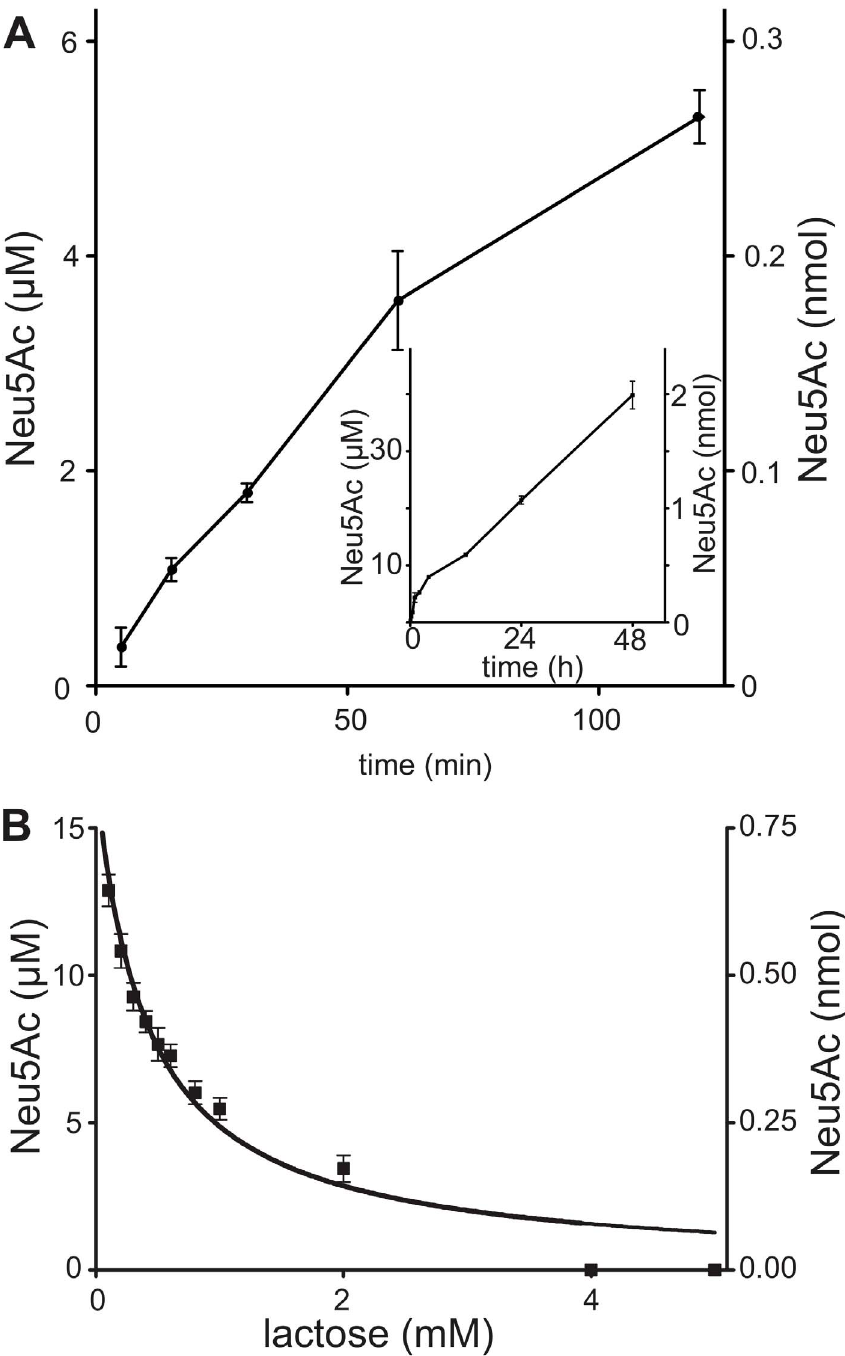
Figure 5. Sialidase activity of TconTS4. A : Recombinant TconTS4 was incubated with 100 m g fetuin (600 m M bound Sia) for the times indicated (see insert for long term reactions) and free Sia determined by HPAEC-PAD as described under Methods. Data points are means 6 standard deviations of 3 independent reactions each triplicated. B : Recombinant TconTS4 was incubated for 1440 min with 100 m g fetuin (600 m M bound Sia) in the presence of the lactose concentrations indicated and free Sia determined by HPAEC-PAD as described under Methods. Data points are means 6 standard deviations of 3 independent reactions each as triplicates.